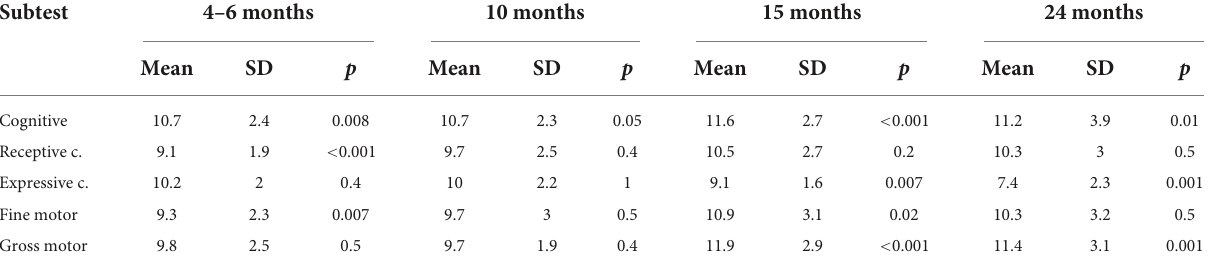
TABLE 2 Scaled scores of child development.